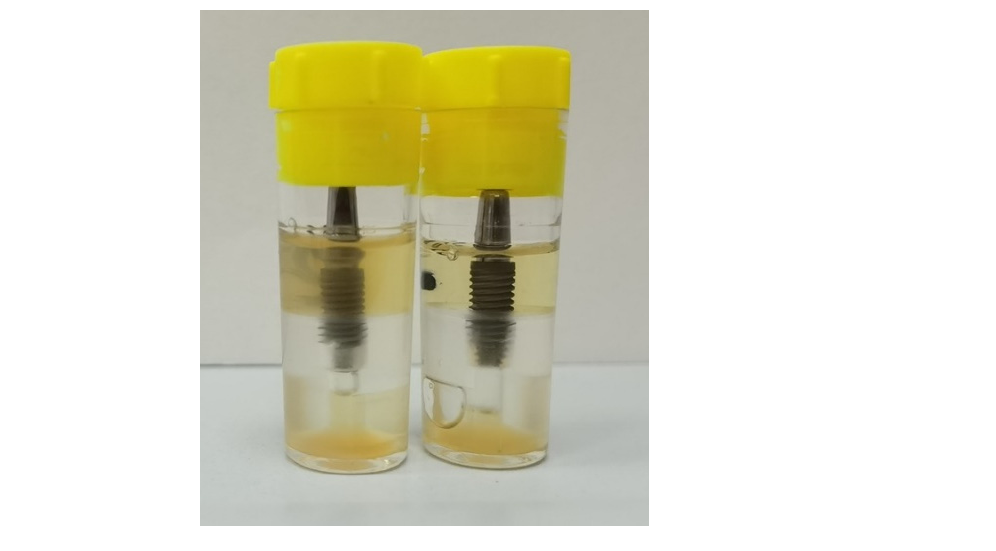
Figure 6. Samples placed into the nutrient solution during the follow-up. Left = turbidity of the broth as a sign of bacterial penetration; Right = no contamination.